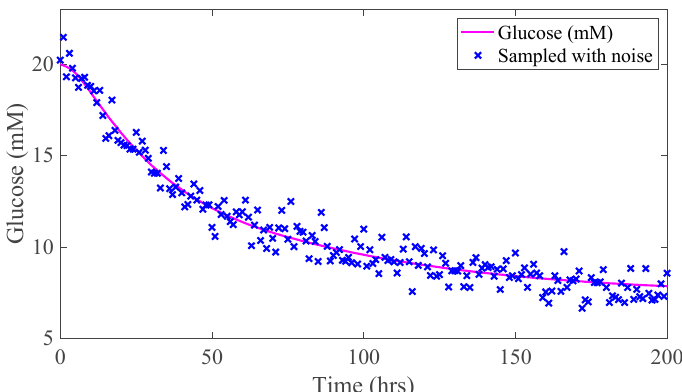
Processes 2022 , 10 , 1448 Figure 1. The true glucose concentration and infrequent measurement with noise when F in = 0 L h − 1 .